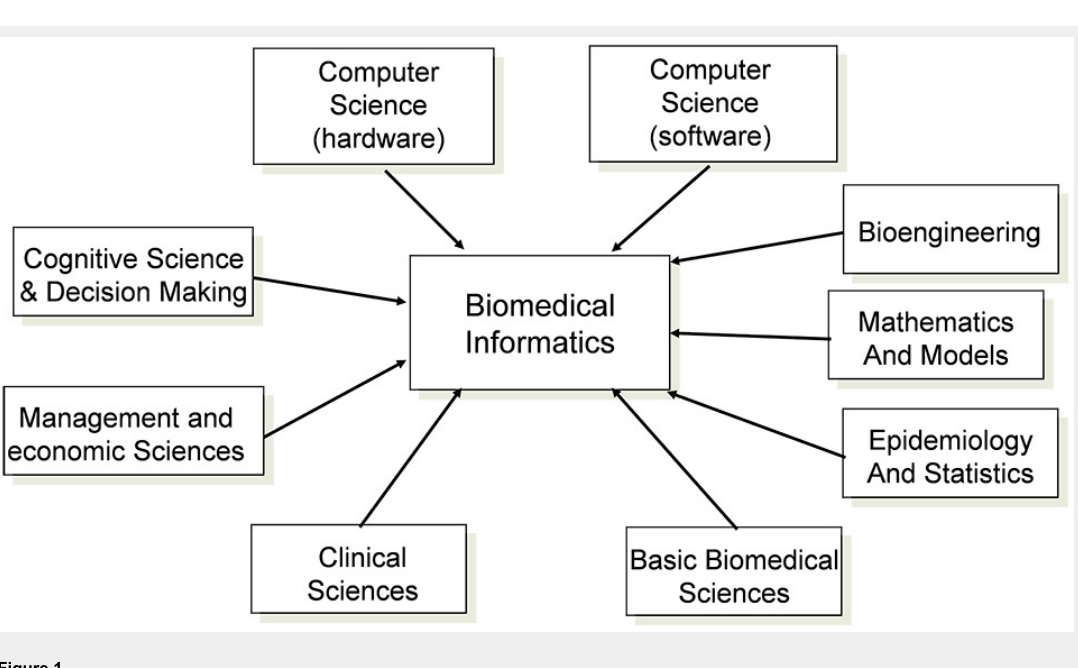
Biomedical informatics is a field of science at the intersection of other domains and is interdisciplinary by essence [1].